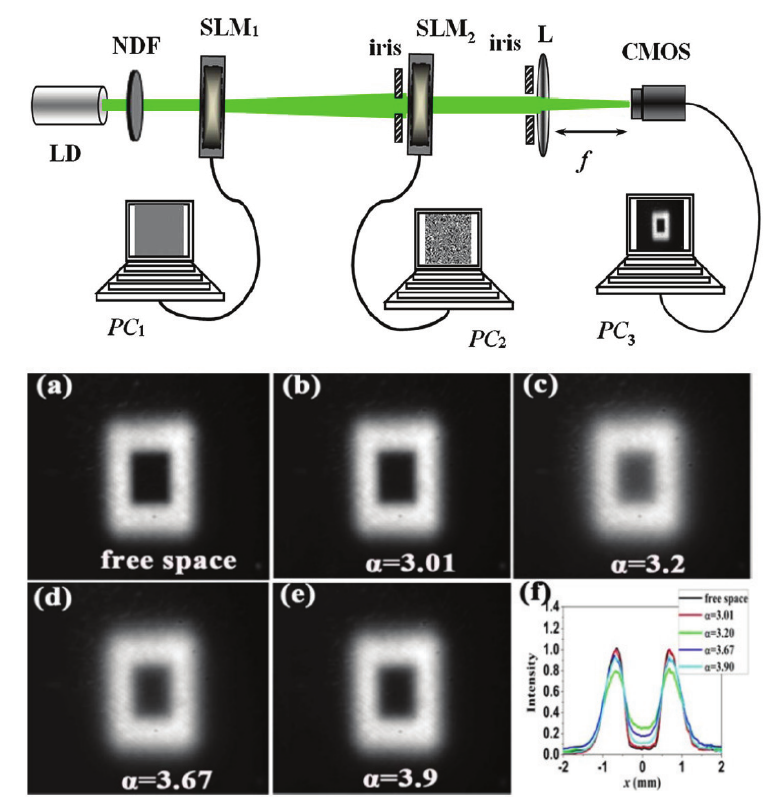
Figure 12. The two-SLM setup for generation of any pre-modulated beam ( SLM 1 ) and simulating its interaction with non-Kolmogorov turbulence ( SLM 2 ). LD —laser diode, NDF —neutral density filter, L —lens, CMOS —complementary metal oxide semiconductor camera, PC 1 , PC 2 and PC 3 are personal computers. ( a – e ) Generated frame-like beams passing through simulated turbulence with different α ; ( f ) comparison of cross-sections. Printed with permission from Reference